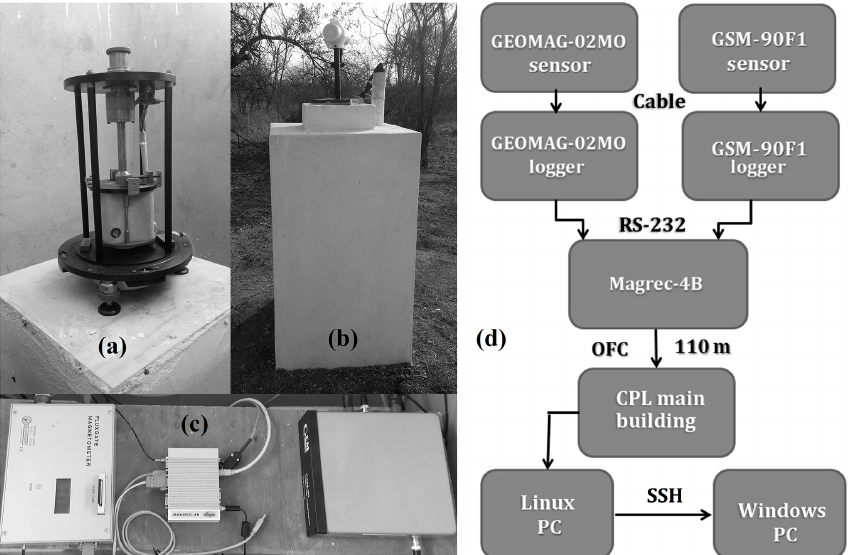
Figure 3. (a) Three-component GEOMAG-02MO; (b) GSM-90F1; (c) data loggers of the GEOMAG-02MO, GSM-90F1 and Magrec-4B data acquisition system; and (d) flow chart of connections used for the experimental setup.